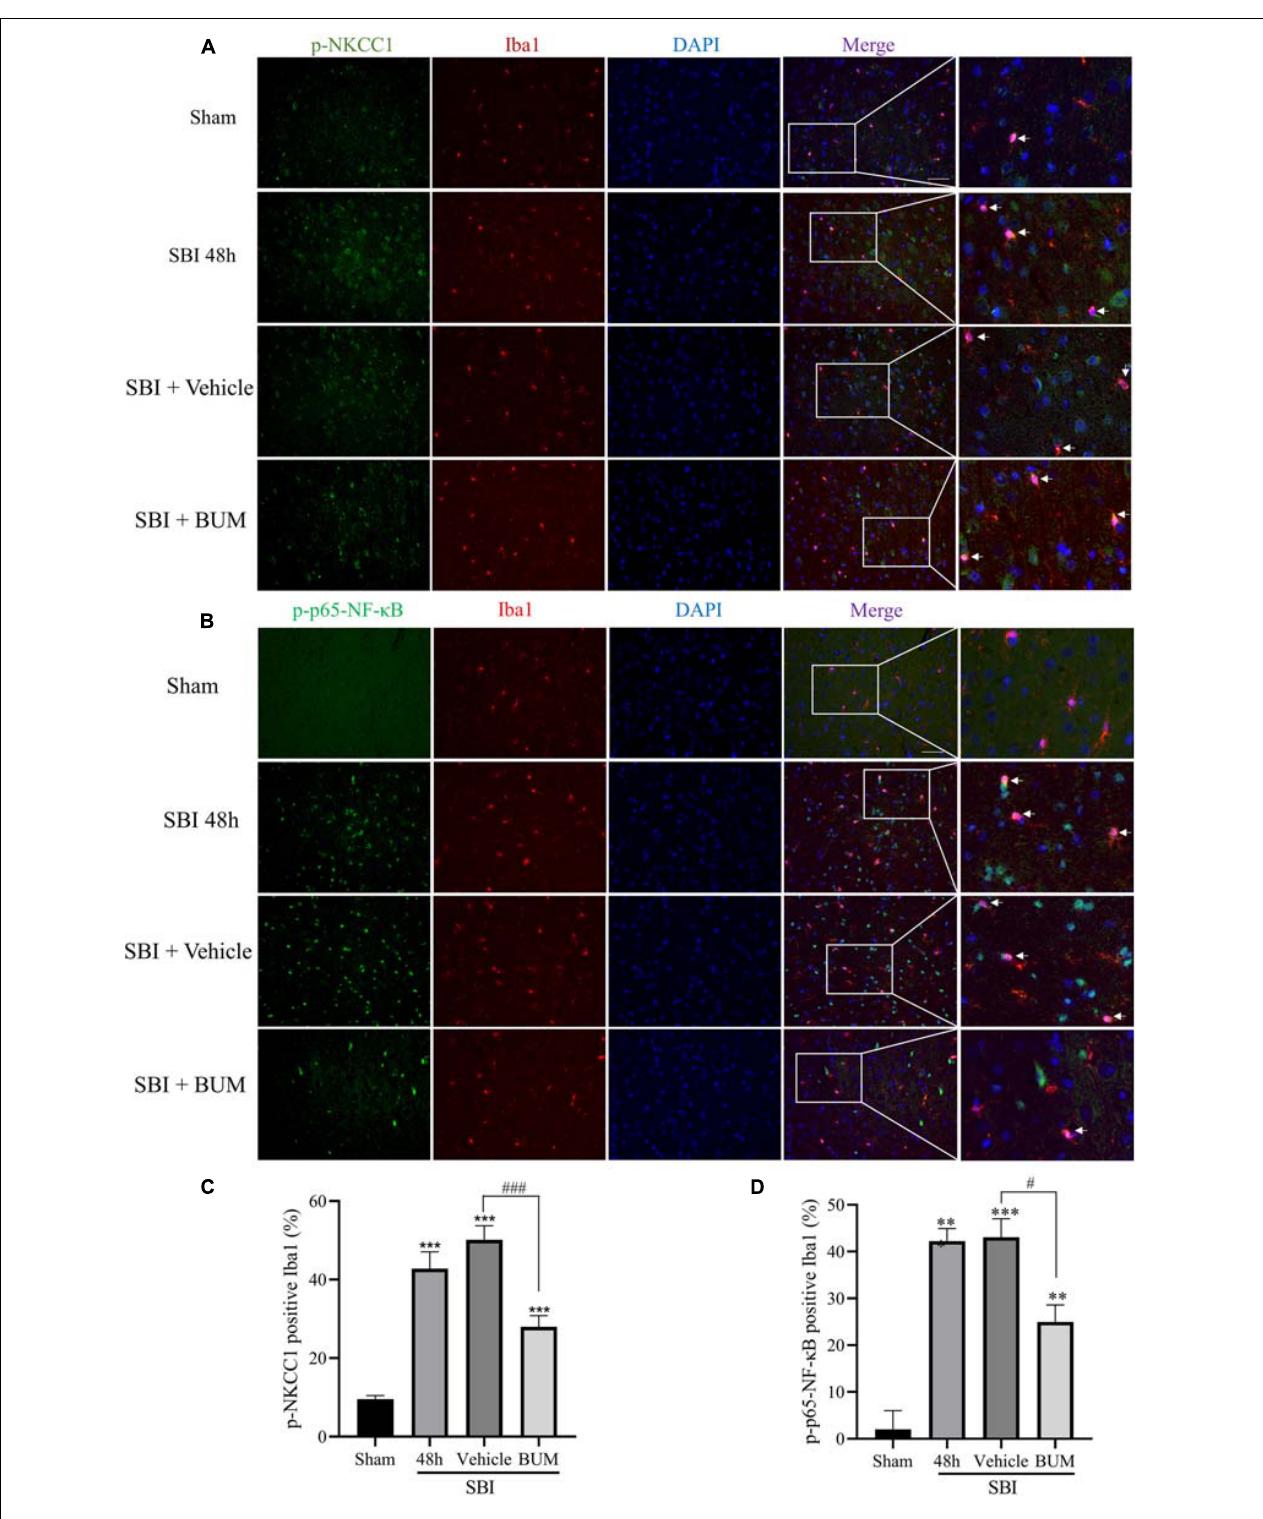
FIGURE 3 | Double IF staining of p-NKCC1 and p-p65-NF- κ B in the peripheral cortex of the damaged area. In the sham group, SBI group, SBI + vehicle group and SBI + BUM group, the expression of green-labeled p-NKCC1 (A,B) , p-p65-NF- κ B (C,D) and red-labeled Iba1 were assessed by double IF. The nuclei were stained with DAPI (blue) fluorescence. Arrows show p-NKCC1 and p-p65-NF- κ B co-localization with microglial cells. Scale bar = 50 µ m. Statistical analysis was conducted using a K–W one-way ANOVA, followed by the Student–Newman–Keuls post hoc test. n = 4 for each group. ** P < 0.01, *** P < 0.001, compared with sham group. # P < 0 . 05, ### P < 0 . 001, compared with the SBI + Vehicle group.